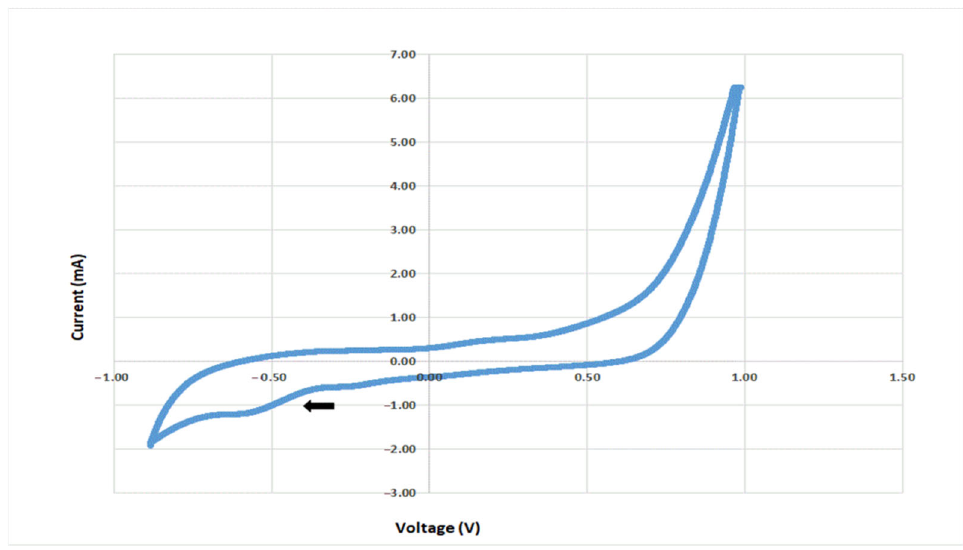
Figure 3. CV (1 mV/s) of C. saccharoperbutylacetonicum biofilm in TSYE with HCO 3 − 0.25% (0.03 M). The arrow indicates a reduction peak at − 585 mV vs. Ag/AgCl.